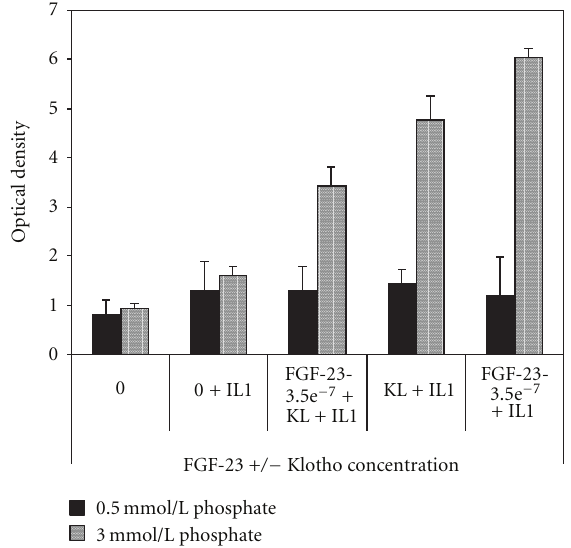
Figure 4: E-selectin production in HUVECs grown in high (3mM) and normal (0.5mM) phosphate concentration media and stimulated with FGF-23, klotho, and